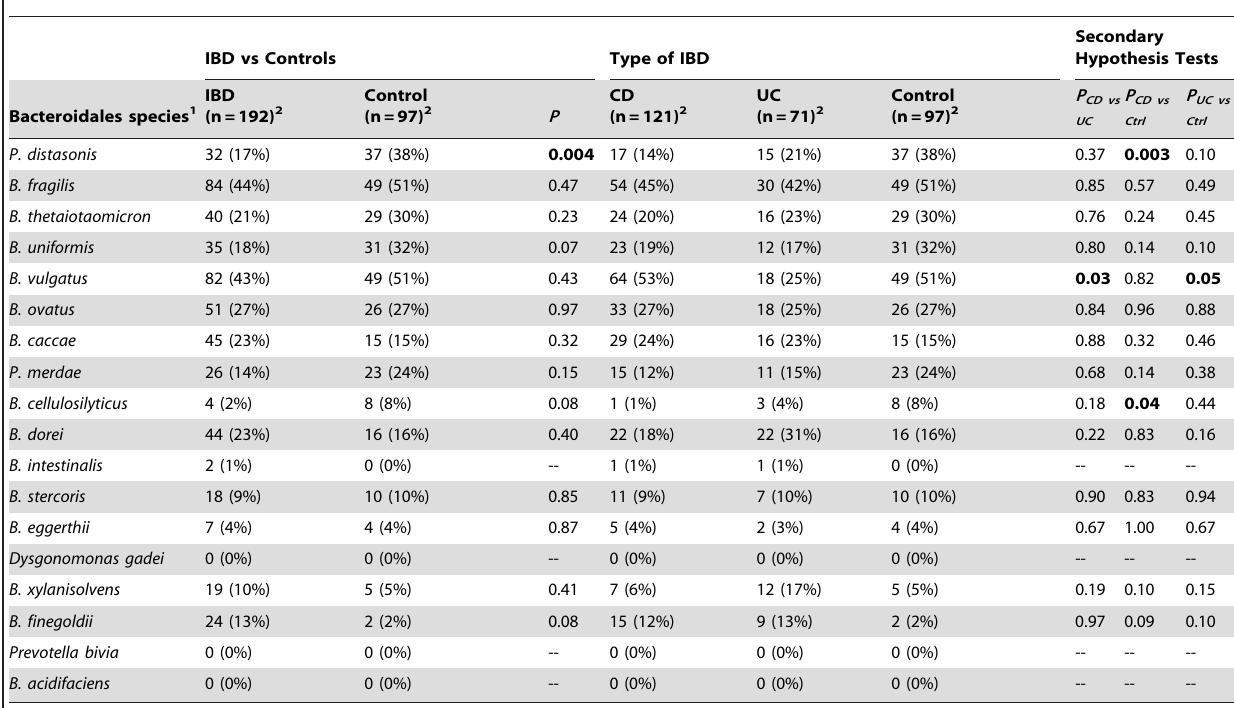
Table 3. Comparison of Bacteroidales species, by disease status (IBD vs. controls) and study group (CD, UC, and controls).